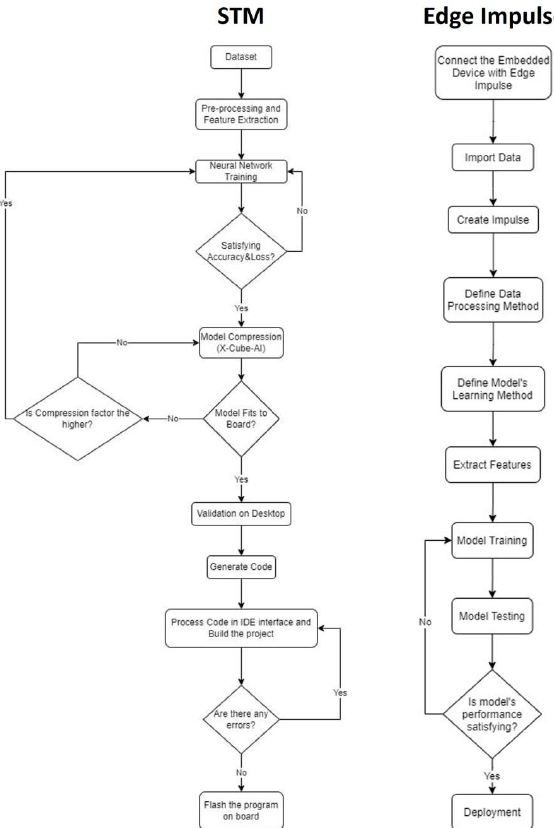
Figure 2. Design flow variants based on the STM software tools and the Edge Impulse platform.